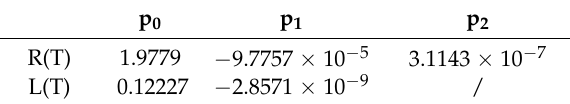
Table 3. Polynomial coefficient of R and